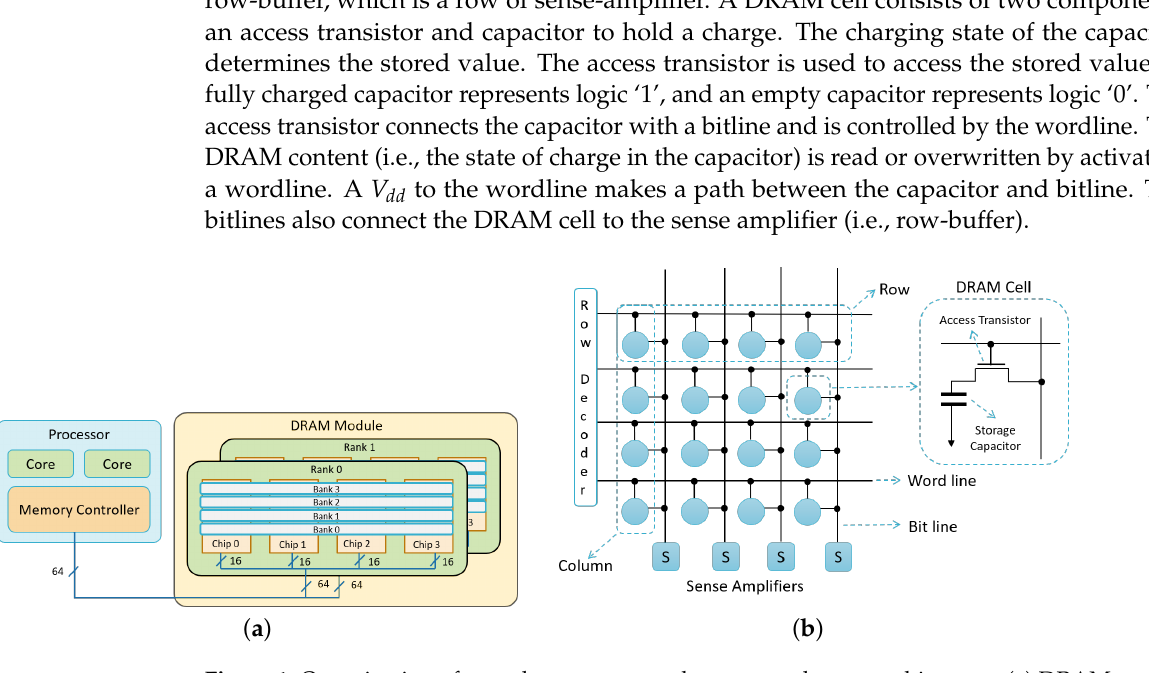
Figure 1. Organization of a modern memory subsystem and array architecture. ( a ) DRAM system hierarchy [14]. ( b ) Array